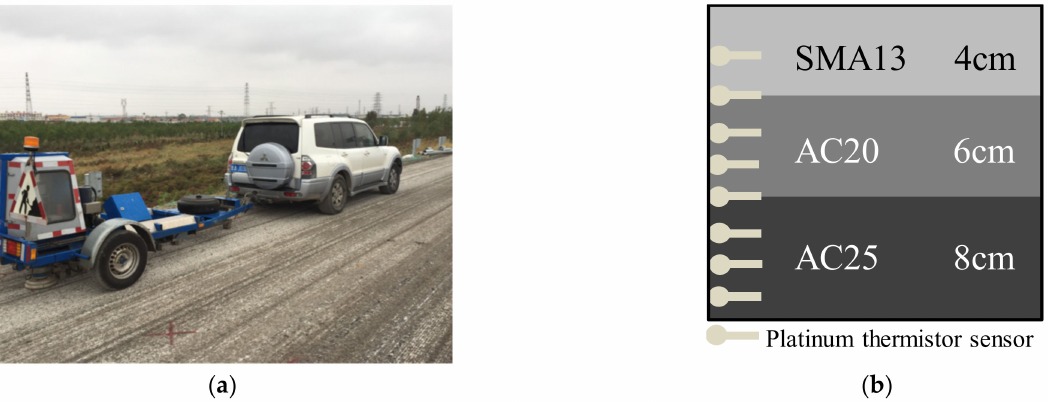
Figure 1. Illustration of the FWD test: ( a ) FWD testing schematic; ( b ) Platinum thermistor sensors’ distribution